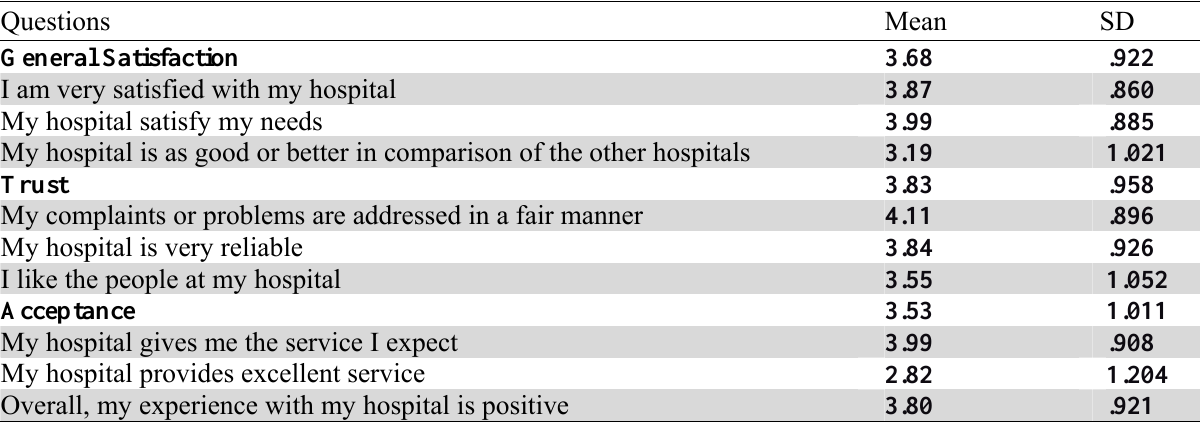
Analysis of patient satisfaction